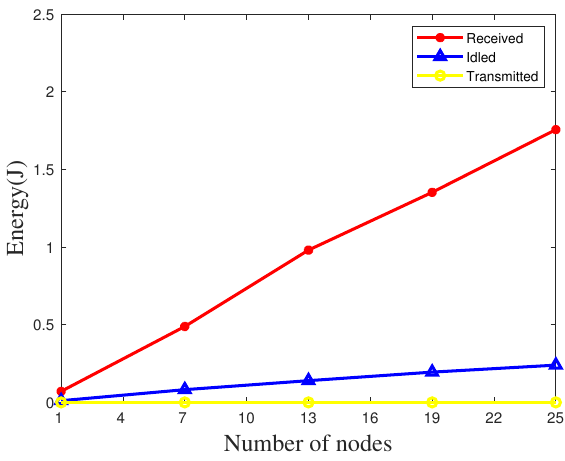
Figure 15. Evaluation of energy consumption indoors.